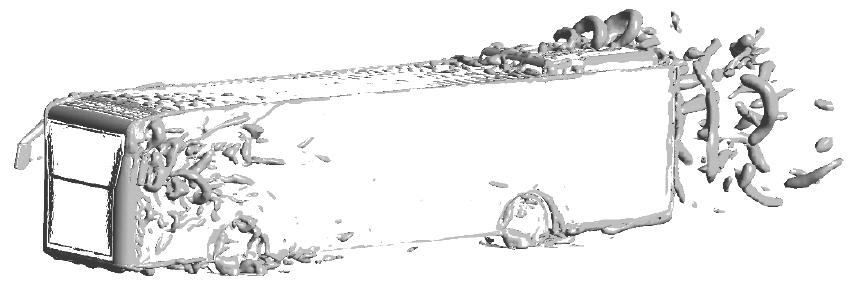
Figure 10. Value of 90 s −2 Q-criterion distribution for model B.